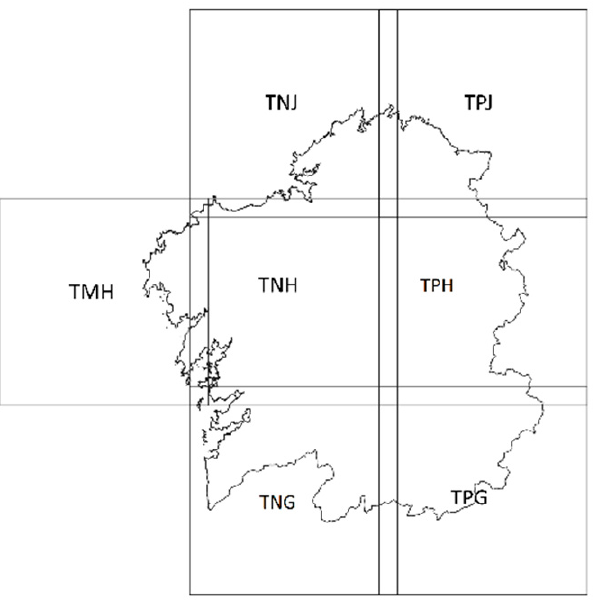
Figure 2. Distribution of the 100 × 100 km 2 Sentinel-2 tiles in Galicia. Level-2A Sentinel-2 products include geometric, radiometric and atmospheric correc- tions. Image pre-processing should be avoided as much as possible in order to develop the simplest methodology and make the method feasible for forest managers and decision mak- ers. However, the downloaded images were visually analyzed, since spectral differences between contiguous tiles in Sentinel-2 products with Level-2A corrections were reported by Kukawska et al. [57], and due to the fact that this phenomenon could compromise results. Differences in radiometric values were noticeable. An example of this is shown in Figure 3. It shows the images (with RGB color compositions) from two neighboring tiles. Both images were captured on the same date (19/07/2019) and with the same satellite